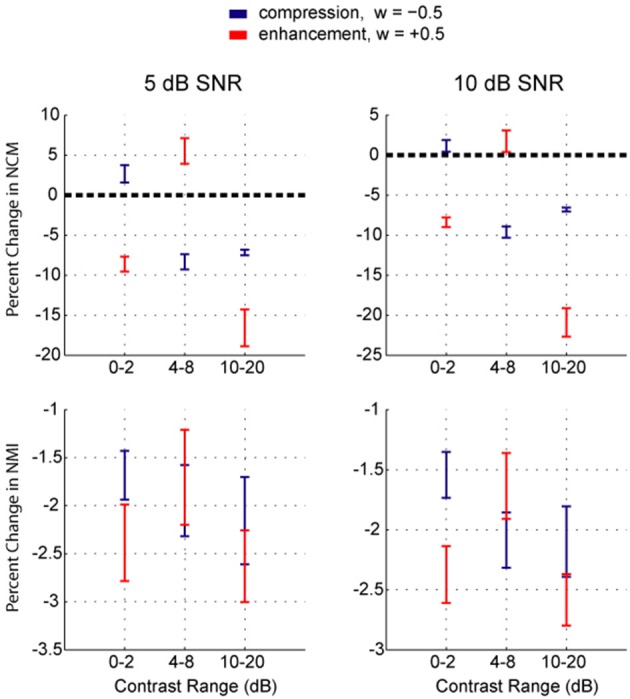
Results of weightings applied to low, intermediate, and high contrast regions. Either compression (−0.5) or enhancement (+0.5) weightings were applied to one of low, intermediate, or high contrast ranges of speech in Gaussian additive white noise at 10 dB SNR (left) and 5 dB SNR (right) (n = 10 sentences), with no weighting applied to the other ranges. The mean percent change in NCM and NMI scores is shown with error bars representing the SEM. The NCM scores show that enhancing low contrasts (mostly noise) or high contrasts (mostly speech) degraded intelligibility as predicted. Enhancing intermediate contrasts improved intelligibility on the average, as did compressing low contrasts. Compressing intermediate or high contrasts lowered intelligibility by about the same amount. The NMI scores showed similar trends, however the changes were more variable across the group of sentences. Note that because of the data processing inequality, the weightings cannot increase the mutual information.